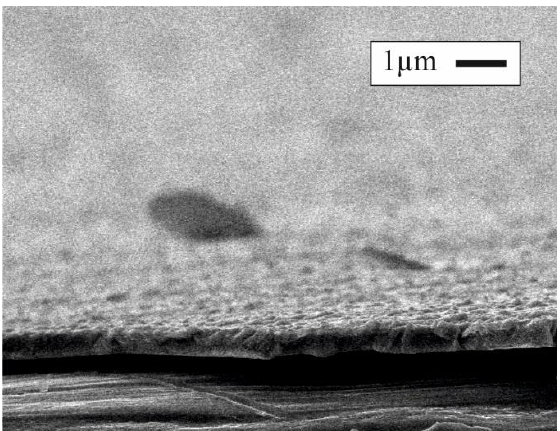
Figure 3. SEM image of the cross section of a slice of contact blade after the deposition of Au sublayer of 700 nm in thickness.